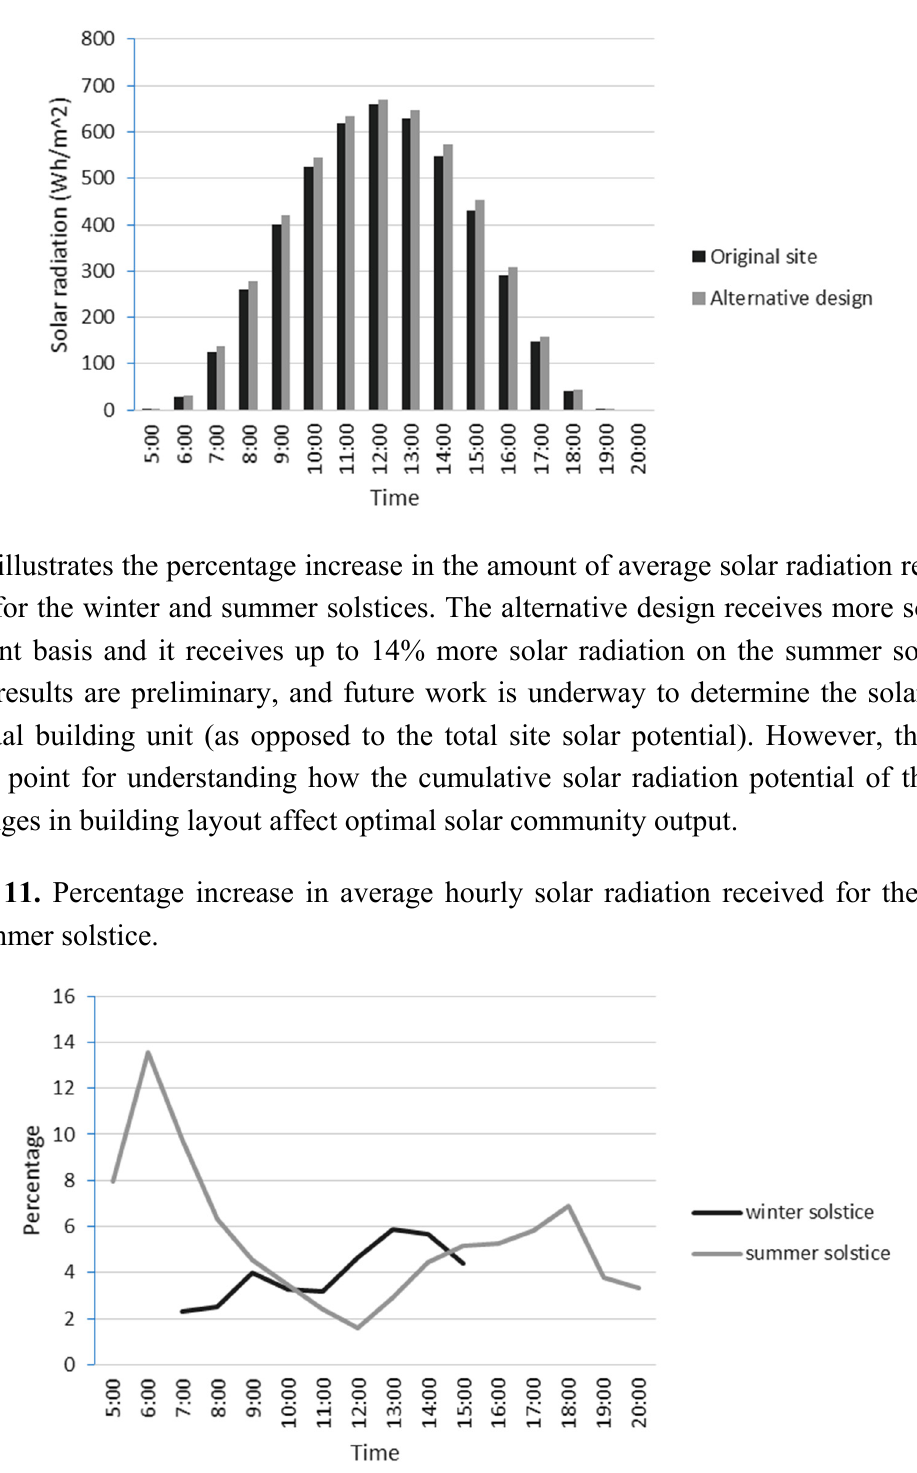
Figure 10. Average hourly solar radiation of case study location on the summer solstice.